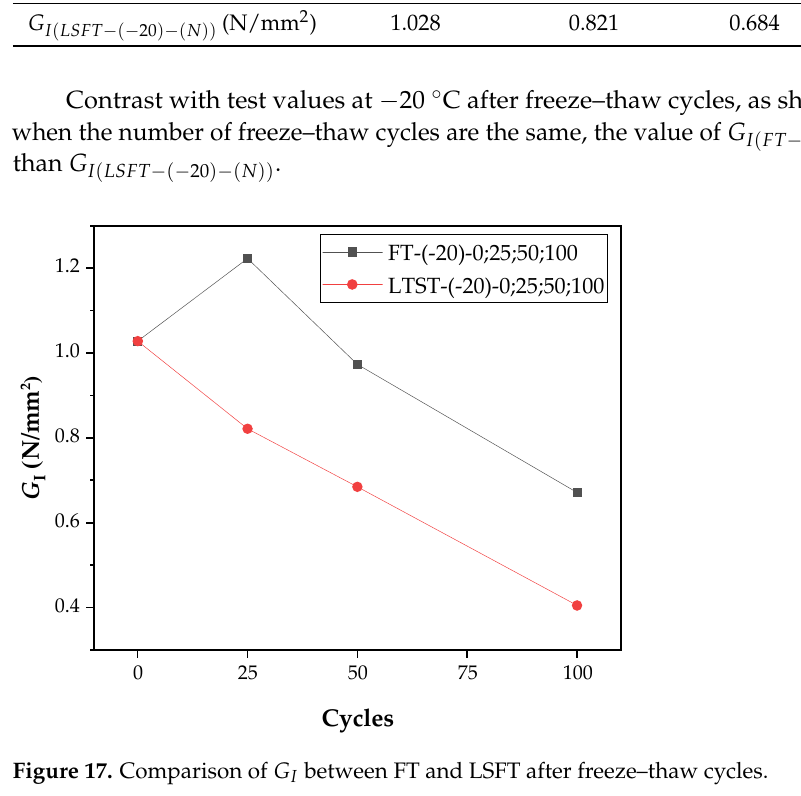
Table 7. Linear superposition fracture energy calculation.